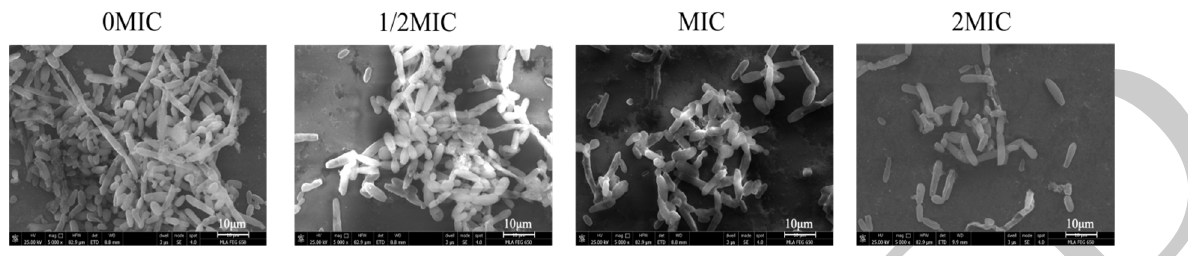
Figure 8. The effect of sanguinarine on the mature hyphae of C. albicans SC5314. The mature hypha of C. albicans SC5314 was treated with indicated concentrations of sanguinarine for 5 h at 37 °C. Each field of vision was magnified 5000×. Scale bars represent 10 μ m.